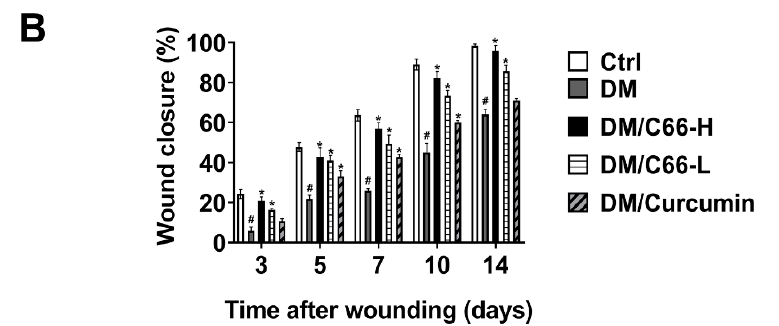
Figure 2. C66 accelerates diabetic wound healing. ( A ) Six millimeter diameter wounds were created by punch biopsy, and the closure of the wound area was measured by digital camera until day 14. ( B ) Percentage of wound closure (means ± S.D.). Healing of diabetic wounds significantly delayed compared with normal wounds. The C66 group began to improve diabetic wound closure on day 3. At the end of the observation period (14 days), the C66 treatment group exhibited improved wound healing, compared with the diabetic group. Data were represented as means ± S.D. * p < 0.05 compared to the diabetes group value, # p < 0.05 compared to the control value. DM and Ctrl are short for the diabetic and control group, respectively.